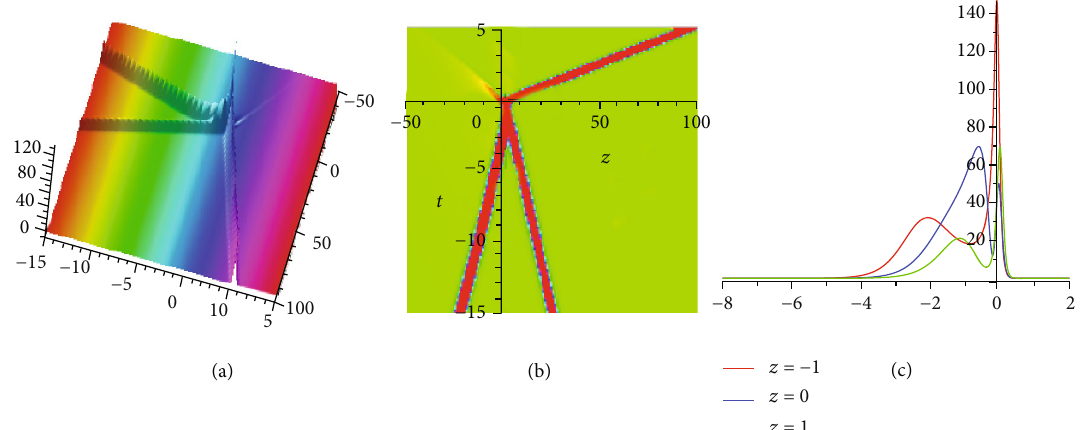
Figure 25: Plots of lump-three kink solutions